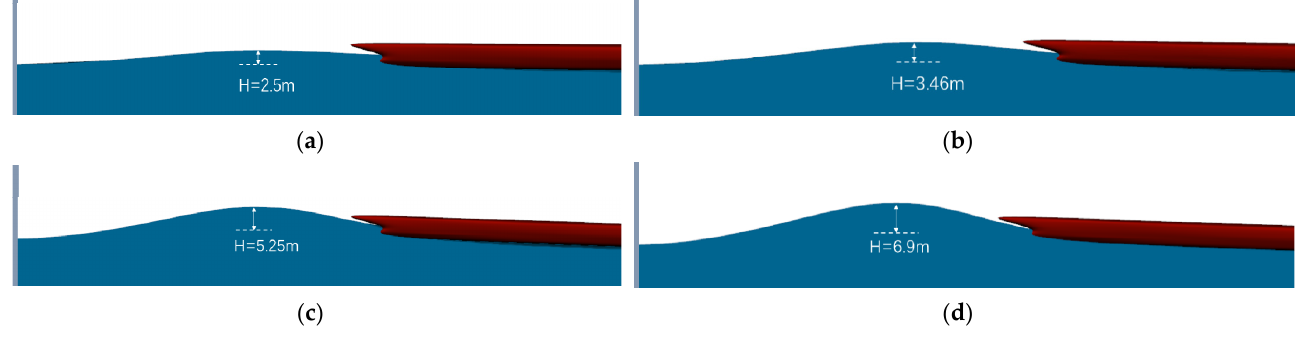
Figure 8. Four models with different levels of wave height: ( a ) four-level sea state simulation scheme, ( b ) five-level sea state simulation scheme, ( c ) six-level sea state simulation scheme, and ( d ) seven-level sea state simulation program.